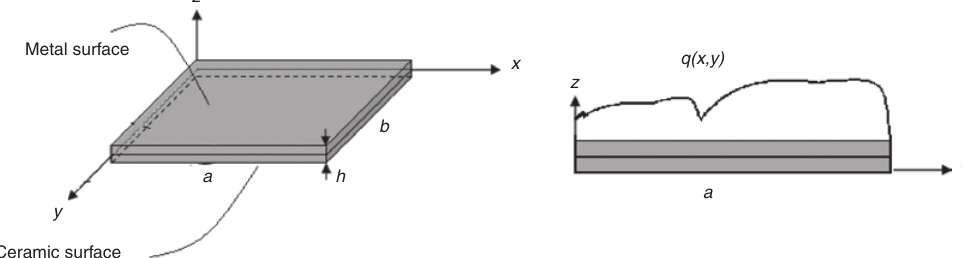
Figure 1: Rectangular micro-plate subjected to distributed